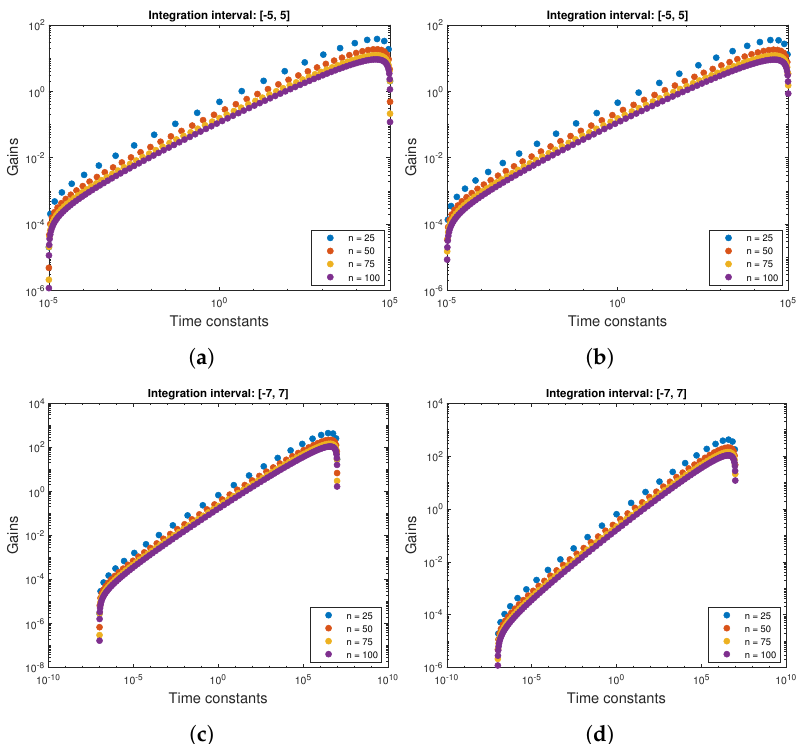
Figure 14. Comparison of time gains and time constants for bounded domain quadratures. For both methods distribution of gain-time constant pairs is similar with concentration of time constants ant the integration interval boudary ( a ) Clenshaw–Curtis quadrature on the [ − 5,5 ] interval; ( b ) Gauss–Legendre quadrature on the [ − 5,5 ] interval; ( c ) Clenshaw–Curtis quadrature on the [ − 7,7 ] interval; ( d ) Gauss–Legendre quadrature on the [ − 7,7 ]